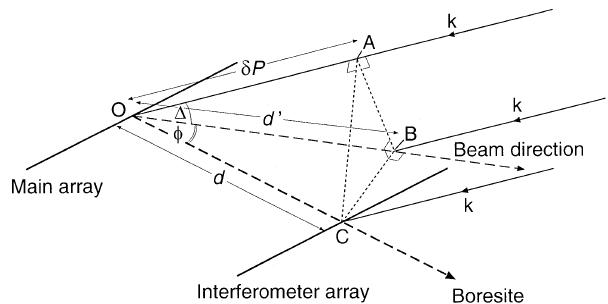
Fig. 3. The geometry of the CUTLASS